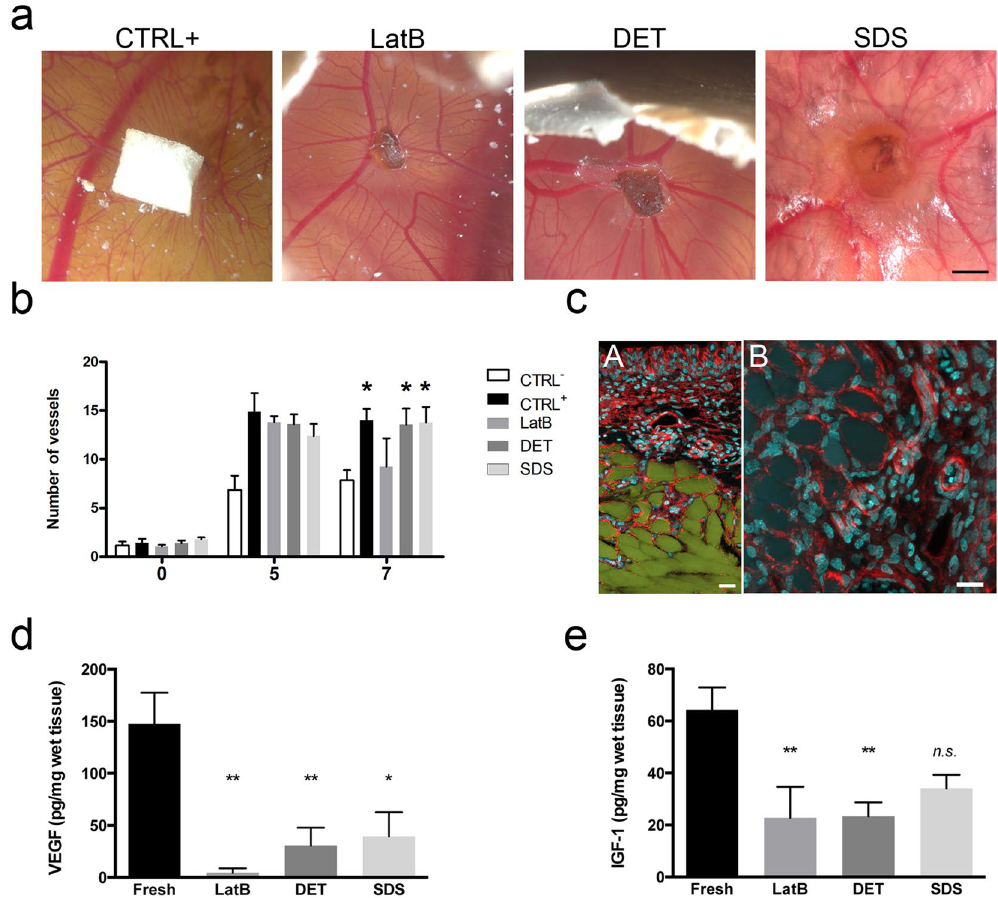
Figure 3. Angiogenetic properties and chemokine maintenance of decellularised skeletal muscles. ( a ) Representative images of CAM assay performed for filter embedded with VEGF (positive control, CTRL + ), and LatB-, DET- and SDS-acellular muscles. Scale bar: 2 cm. ( b ) Quantification of vessel converged toward filter loaded with PBS (negative control, CTRL-) or VEGF (positive control, CTRL + ) and LatB-, DET- and SDS-acellular muscles at the moment of the implantation (0), 5 or 7 days after implantation. The number of vessels significantly increased 7 days after implantation (0) in CTRL + , DET and SDS samples. Data are shown as mean ± s.e.m of three independent replicates; no significant differences were observed among the three scaffolds and positive control; n = 4 independent experiment per each group. ( c ) Representative images of DET- acellular muscle cryosections 7 days after egg implantation, and stained with phalloidin (red) and dapi (blue). Autofluorescence of the scaffold (green) is also showed in panel A. Panel B, higher magnification of phalloidin (red) and dapi (blue). Scale bar: 25 µ m. ( d ) Quantification of VEGF content in freshly isolated rat skeletal muscle and LatB-, DET- and SDS-decellularised muscles. Data are shown as mean ± s.e.m of three independent replicates; * P < 0.05; ** P < 0.01, each decellularised sample compared to fresh muscles; one-way ANOVA and Tukey’s multiple comparison test; no significant differences were observed among the decellularised samples; n = 6–12, each group. ( e ) Quantification of IGF-1 content in freshly isolated skeletal rat muscles and LatB-, DET- and SDS-decellularised muscles. Data are shown as mean ± s.e.m of three independent replicates; ** P < 0.01, each decellularised sample compared to fresh muscles; n.s., not significant; one-way ANOVA and Tukey’s multiple comparison test; no significant differences were observed among the decellularised samples; n = 4–8, each